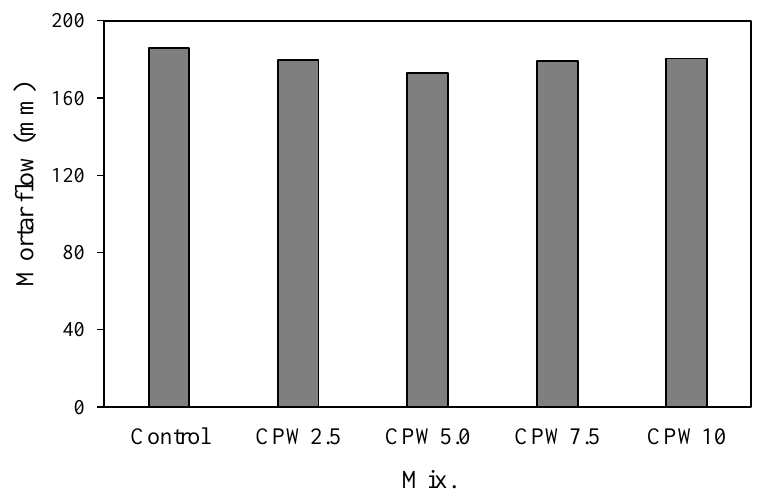
Figure 6. Mortar flow of the samples.